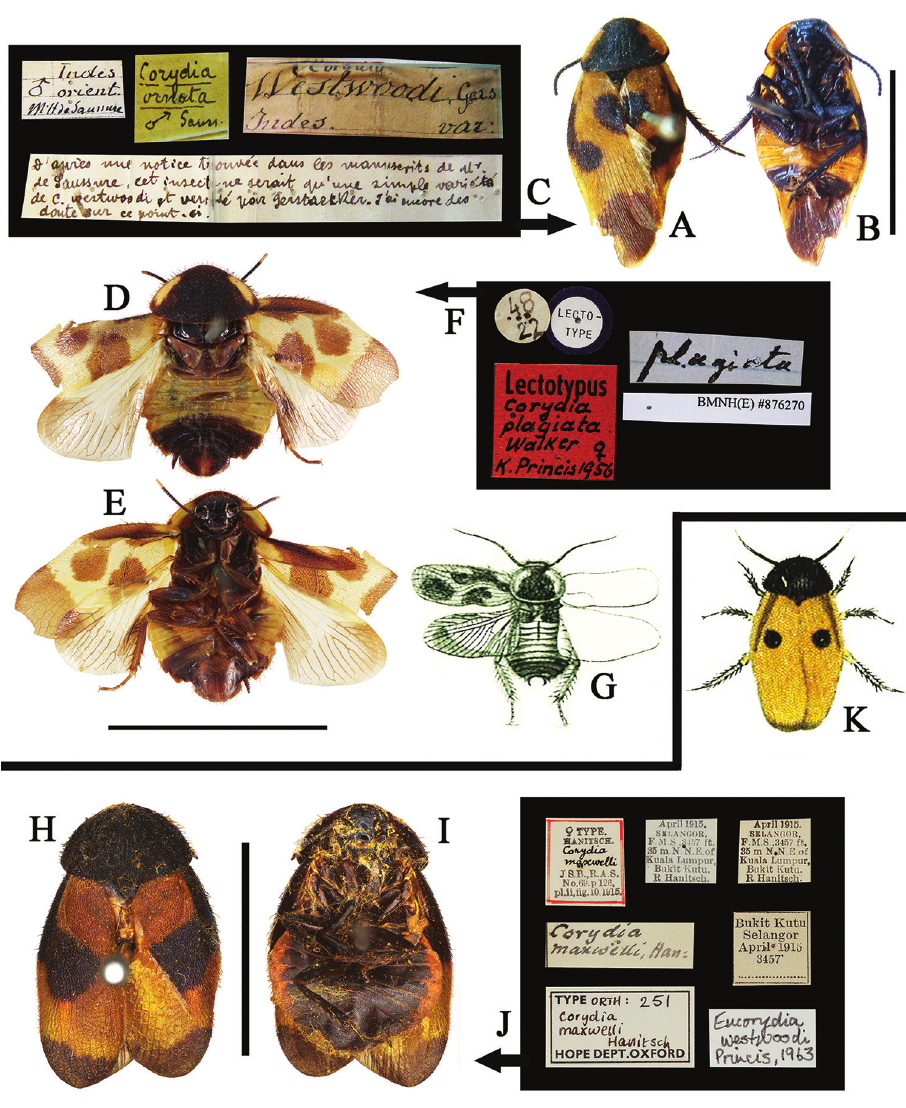
Figure 13. A–K Eucorydia species outside China A–G E. plagiata : A–C holotype of Corydia ornata , male [A–C photographed by Peter Schwendinger, copyright Museum of Natural History, Geneva, Swit- zerland (GMNH)] D–F lectotype of Corydia plagiata , female [D–F photographed by Zong-Qing Wang, copyright by The Natural History Museum, United Kingdom (NHM)] G original figure of Corydia el- egans in Brunner von Wattenwyl (1893) H–K E. maxwelli : H–J type of Corydia maxwelli , female K origi- nal figure of male Corydia maxwelli in Hanitsch (1915) [ H–J photographed by Katherine Child and provided by Amoret Spooner, copyright Oxford University Museum of Natural History, Oxford (OUM)]. Scale bars 10